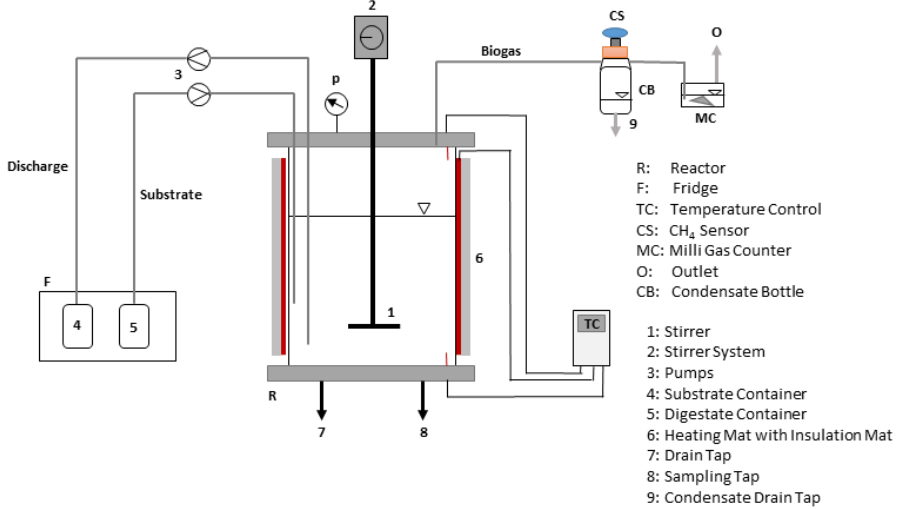
Figure 1. Experimental setup of the continuous fermentation test with CSTR.